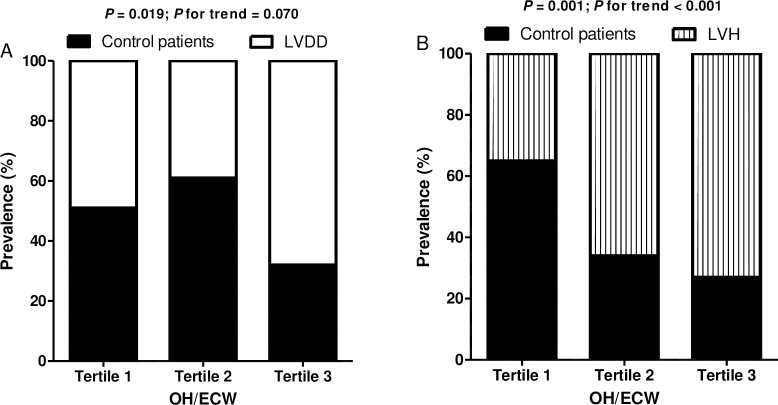
Comparison of the percentage distribution of subjects according to the tertile distribution of OH/ECW.A) LVDD; chi-squared test, P = 0.019, B) LVH; chi-squared test, P = 0.001.